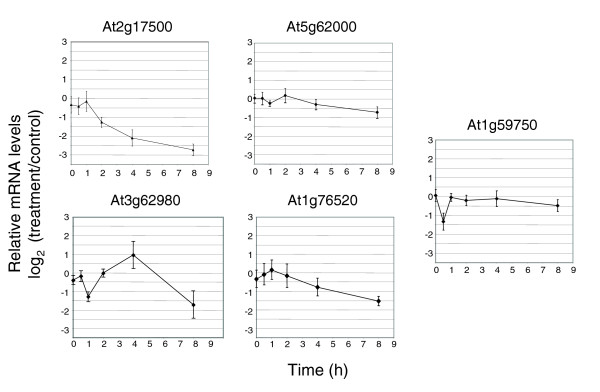
Time course of CN response for genes involved in the auxin response. We monitored the mRNA levels over time for five genes selected from Table 2. We performed three biological replicates, each with a technical replicate. Each graph shows the average expression and standard error of the mean for at least five data points. All mRNA levels were normalized to clathrin. Y-axis, average log2 (treatment/control); x-axis, time in hours. At2g17500, auxin efflux carrier family protein; At1g59750, auxin-responsive factor (ARF1); At1g76520, auxin efflux carrier family protein; At5g62000, transcriptional factor B3 family protein/auxin-responsive factor; At3g62980, transport inhibitor response 1 (TIR1).